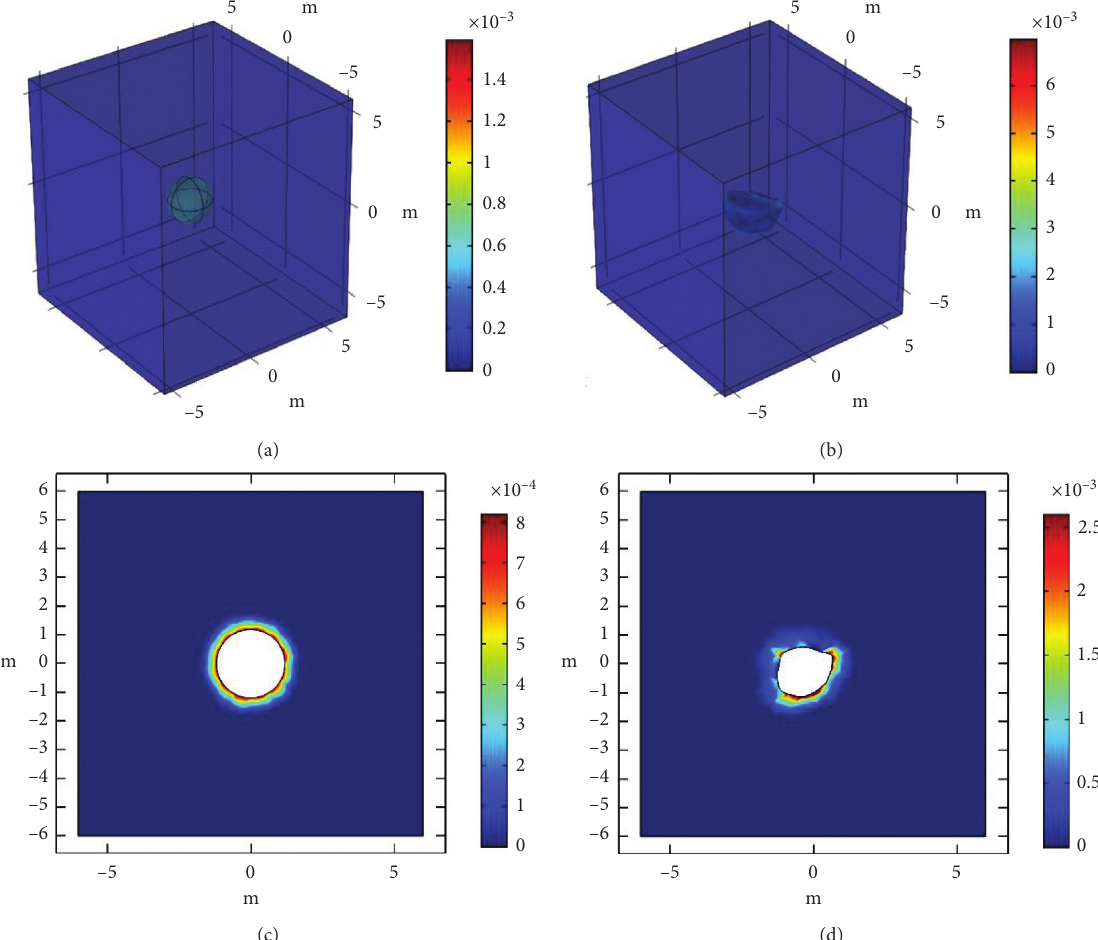
Figure 13: Equivalent plastic strain field of (a) 3D profile using sphere model; (b) 3D profile using the sphere-like model; (c) 2D profile using the sphere model; and (d) 2D profile using the sphere-like model.